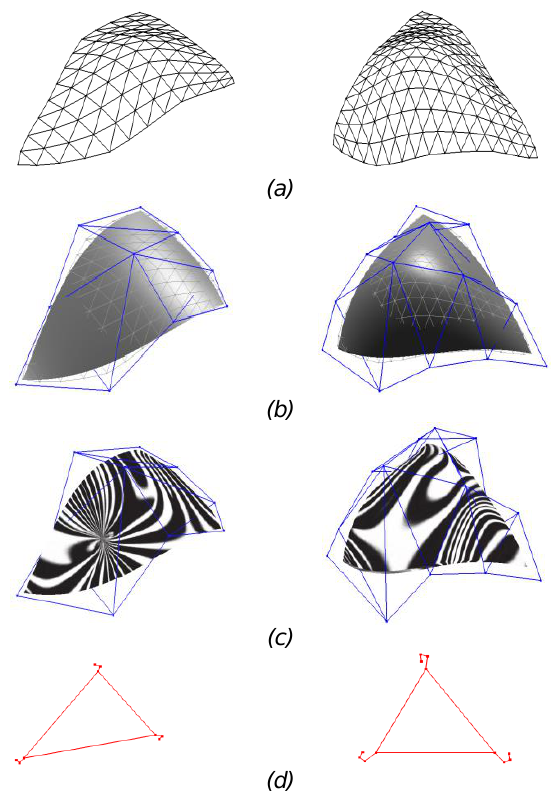
Figure 6. Cubic ( left ) and quartic ( right ) B-patches: ( a ) Initial mesh, ( b ) obtained B-patches and their control meshes after k = 10 steps of the local fitting, ( c ) zebra mapping of ( b ), ( d ) parametric domains and knotclouds of ( b